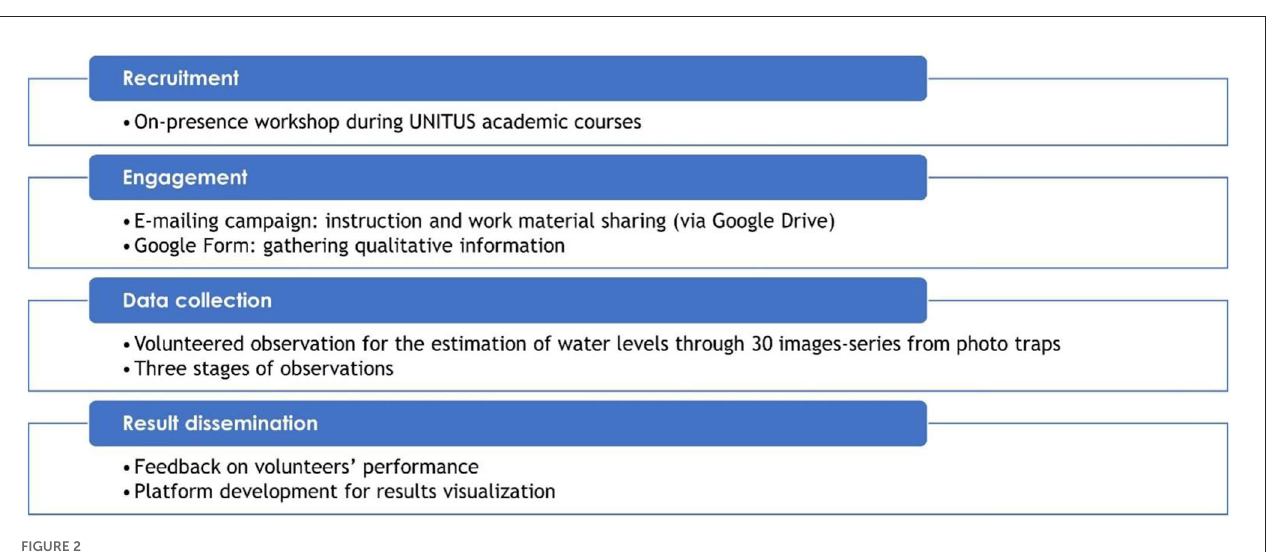
FIGURE2 Methodological procedure adopted to support active participation of volunteers (UNITUS: University of Tuscia, Viterbo,